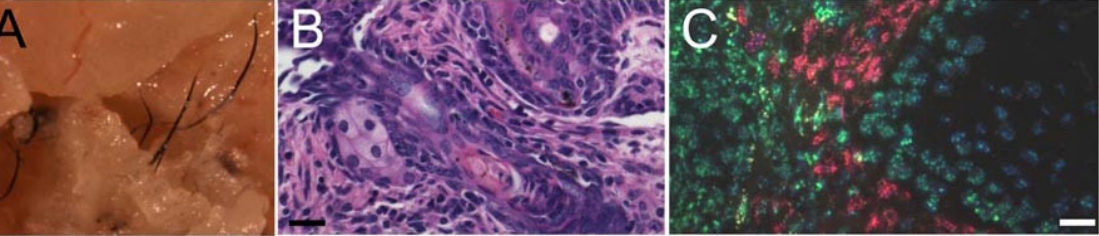
Figure 4. Human dermal papilla (DP) spheroids induce chimeric hair follicles in reconstitution assay. ( A ) Hair fibers in the hypodermis 4 weeks following injection of a mixture of human DP spheroids (10,000 cells/spheroid) and mouse epidermal cells; ( B ) H&E stained horizontal section of injection cyst forming HFs and sebaceous glands; and ( C ) Fluorescence in situ hybridization analysis of the assay site reveals that human DP cells probed with human specific pan-centromeric probe (red) co-exist with the mouse epidermal cells probed with mouse specific pan-centromeric probe (green). Scale bars: A , B and C , 35 μ